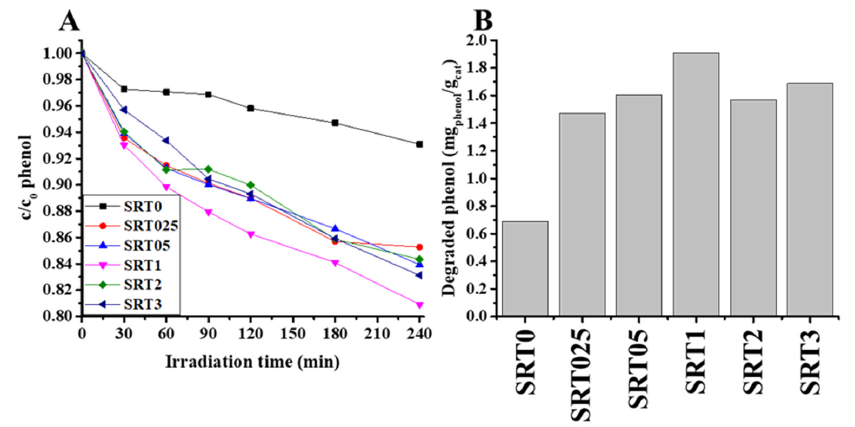
Figure 5. Photocatalytic activity of the SRTX photocatalysts and reference SrTiO 3 , run of decay curves ( A ) and the degraded specific amount of phenol (mg phenol /g cat ) ( B